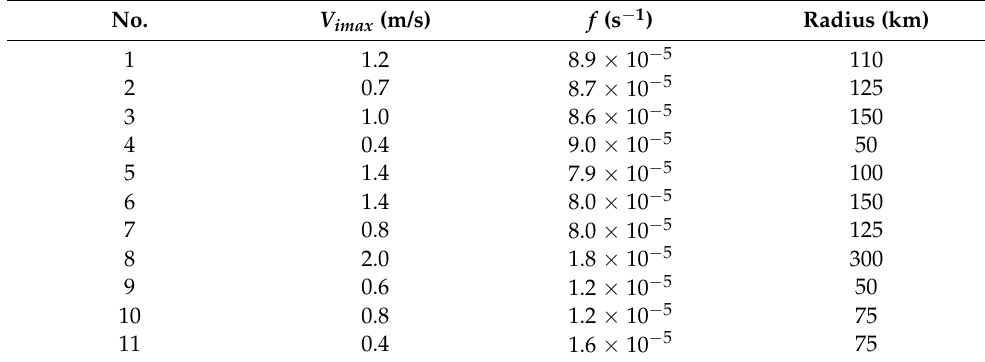
Figure 10. Spatial distribution of the relative difference between the cyclogeostrophic and the geostrophic velocities at different latitudes, different velocities, and different shapes, where ( a ) is the mid-latitudes of the Pacific Ocean on 5 May 2009 and ( b ) is the low-latitudes of the Indian Ocean on 12 August 1998. The vectors represent the cyclogeostrophic velocities. The number represents the eddy code used for the test. Table 2. Information on the eleven selected